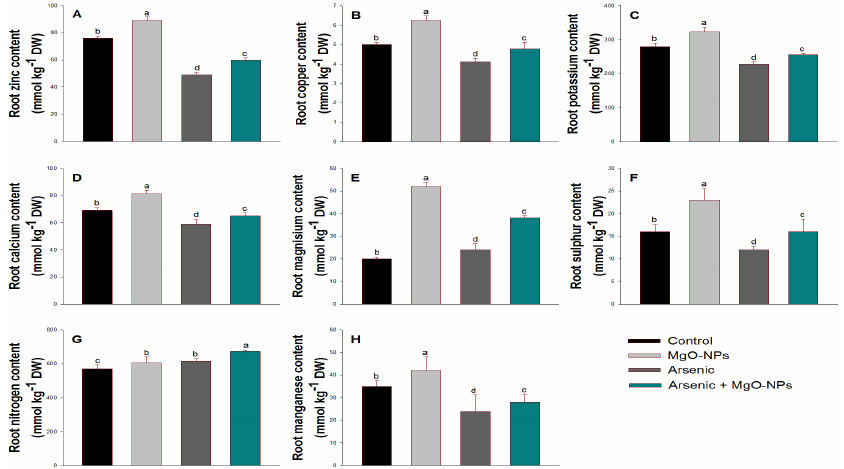
Figure 4. Root content in zinc (Zn) ( A ), copper (Cu) ( B ), potassium (K) ( C ), calcium (Ca) ( D ), magnesium (Mg) ( E ), sulfur (S) ( F ), nitrogen (N) ( G ) and manganese (Mn) ( H ) of soybean plants before and after foliar spray of MgO-NPs in the presence/absence (control) of As. Error bars represent standard deviation and different letters indicate significant differences at p < 0.05.